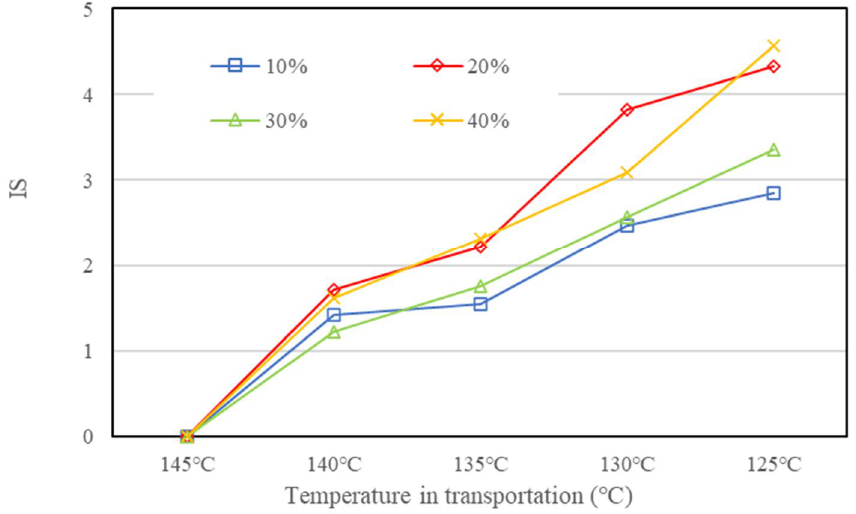
Figure 23. IS of BRA-MA with BRA-5 during